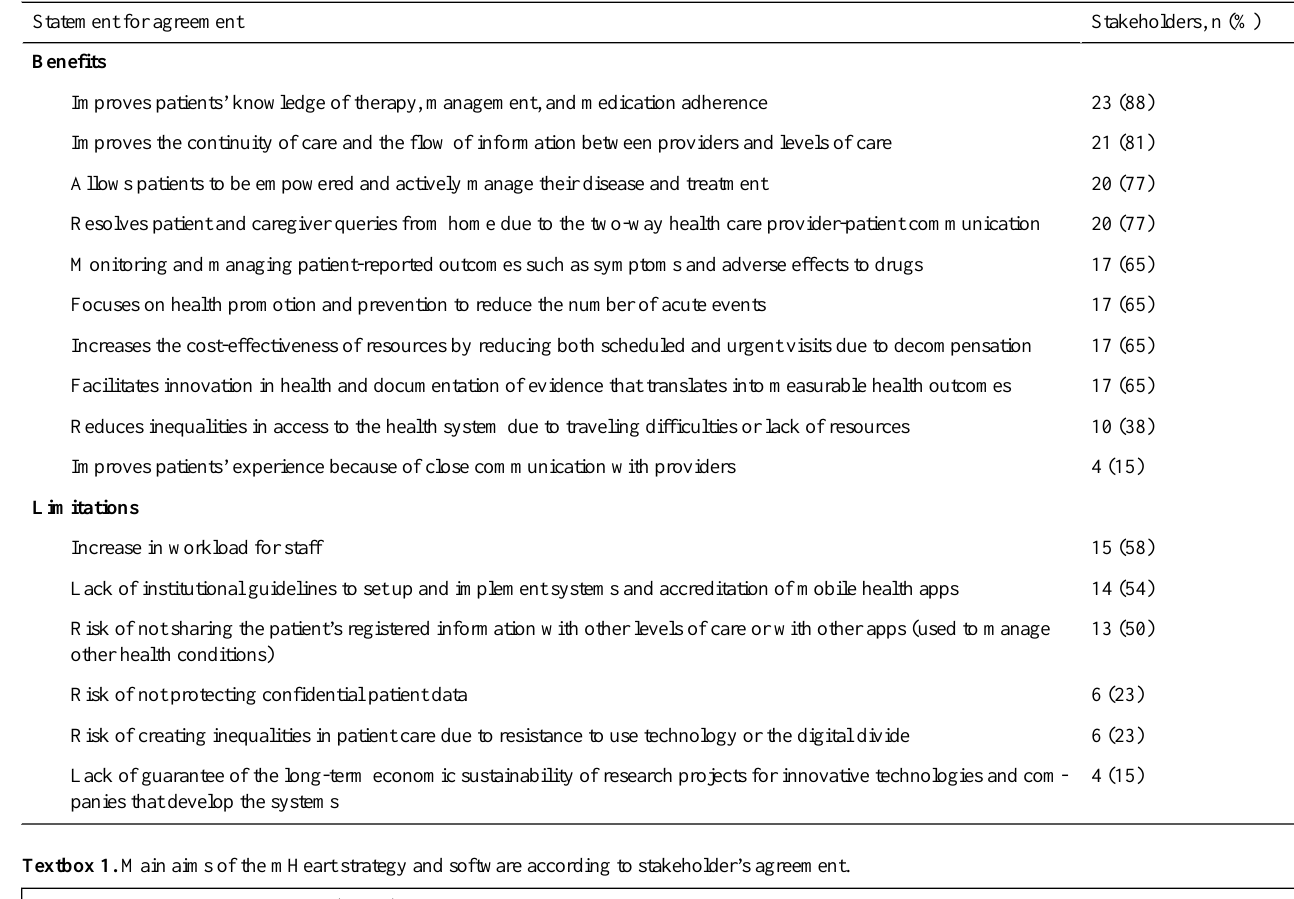
Table 3. Stakeholders’ agreement on the benefits and limitations of a mobile health approach in multimorbid patients with polypharmacy such as the heart transplant population